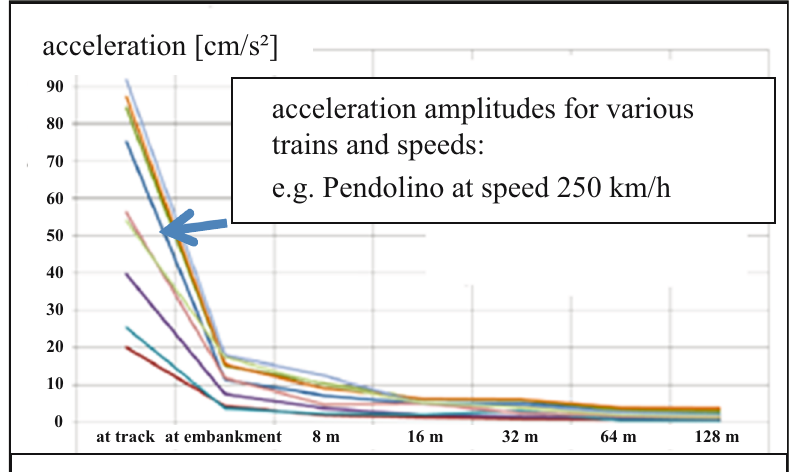
Figure 15: Vibration decay as measured by sensors placed on a line perpendicular to the track, the maximum distance is 128 m and the curves represent various trains that passed the site – the curve for the Pendolino is indicated by an arrow [ 40 ] . Other lines are obtained for lower speeds starting at 60 km/h and for other types of trains, which is less important for the present